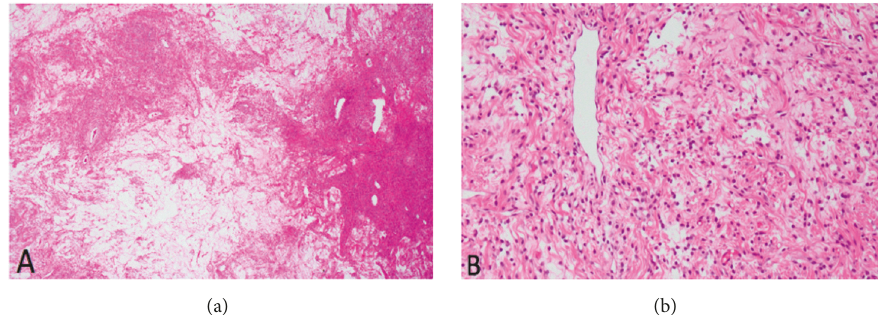
Figure 4: (a) Mesenchymal lesion with alternating hypercellular and hypocellular areas (4x magnification; hematoxylin and eosin stain). (b) Higher magnification demonstrating ovoid and spindle-shaped cells aggregated around small blood vessel (40x magnification).